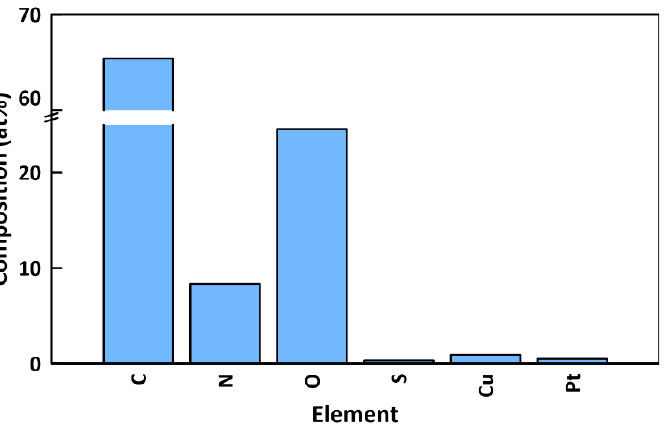
Figure 7. Elemental composition of top surface of functionalized PES/PDA/MPC/CuO membrane, as determined by EDX.